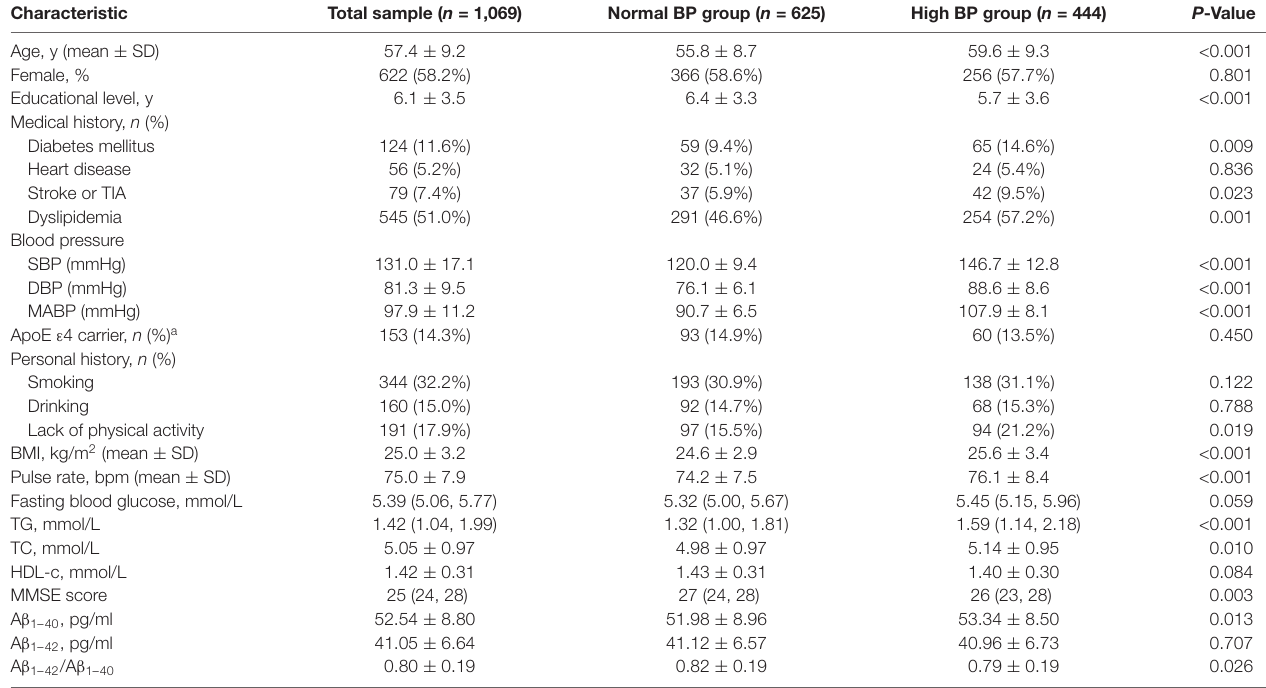
TABLE 1 | Characteristics of the total study population and the population stratified by blood pressure.